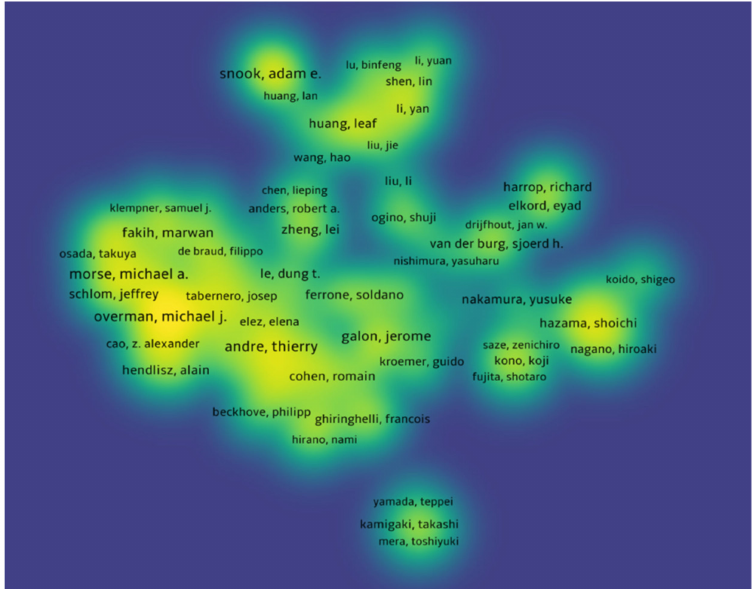
Figure 8. Bibliometric analysis of the authors of publications of immunotherapy in CRC showing authors receiving top citations, where the density indicates the number of citations